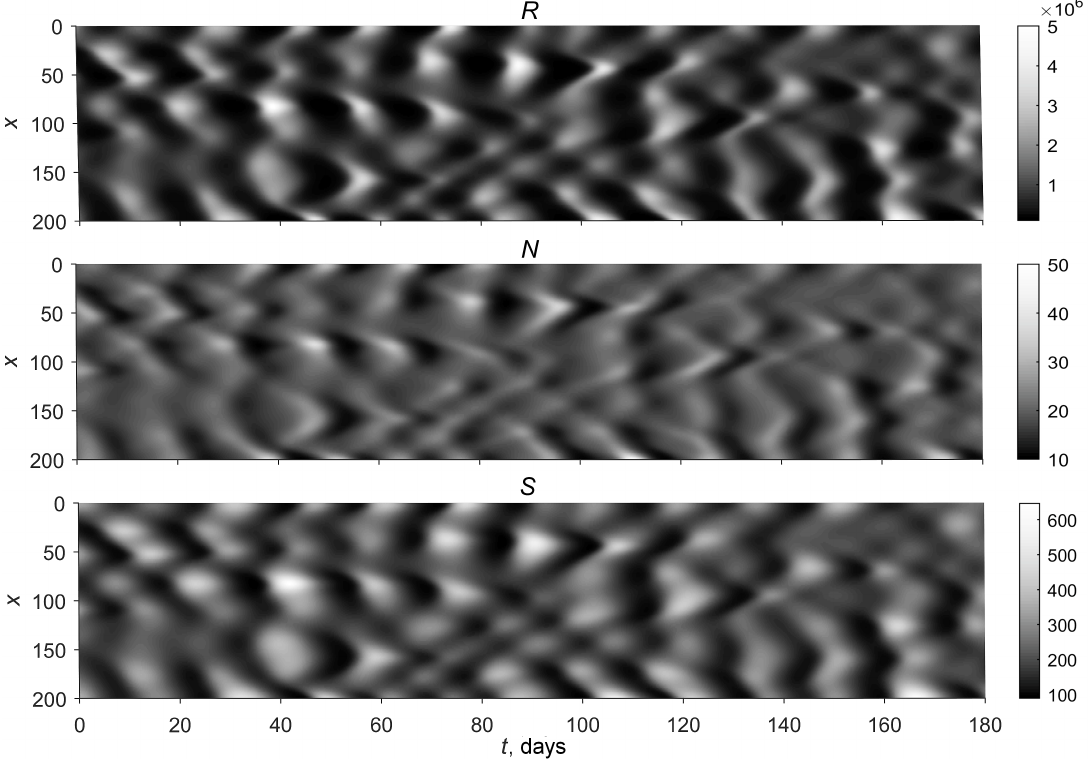
Figure 2. Spatiotemporal dynamics of variables R , N , S at section y = 50cm of domain Ω